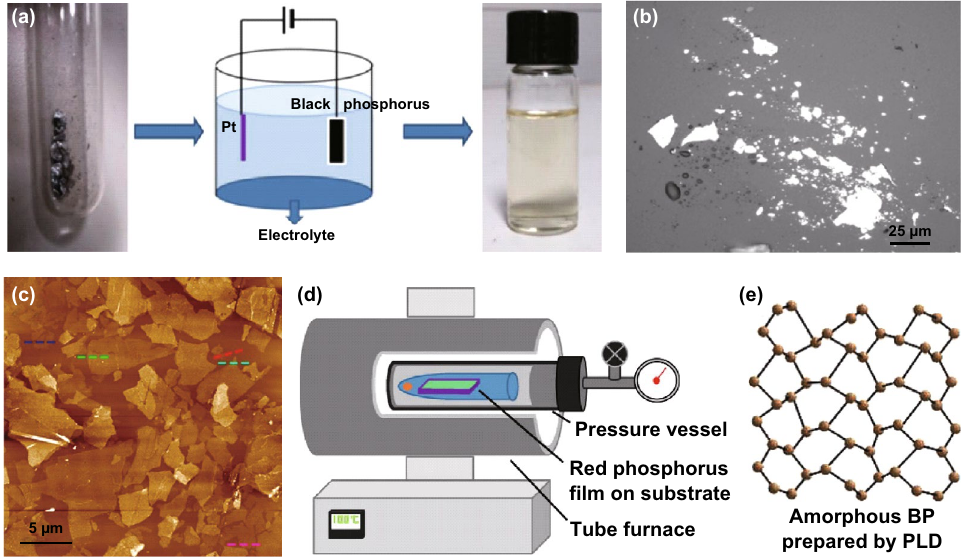
Fig. 3 a Experimental device of BP electrochemical exfoliation [67]. b Optical images of BP nanosheets prepared by electrochemical exfolia- tion [64]. c AFM image of few-layer prepared by electrochemical exfoliation [65]. d The device for synthesizing BP thin films by CVD method [72]. e The top view of disordered atomic structures of BP [74]. Adapted from Refs. [64, 65, 67, 72, 74] with